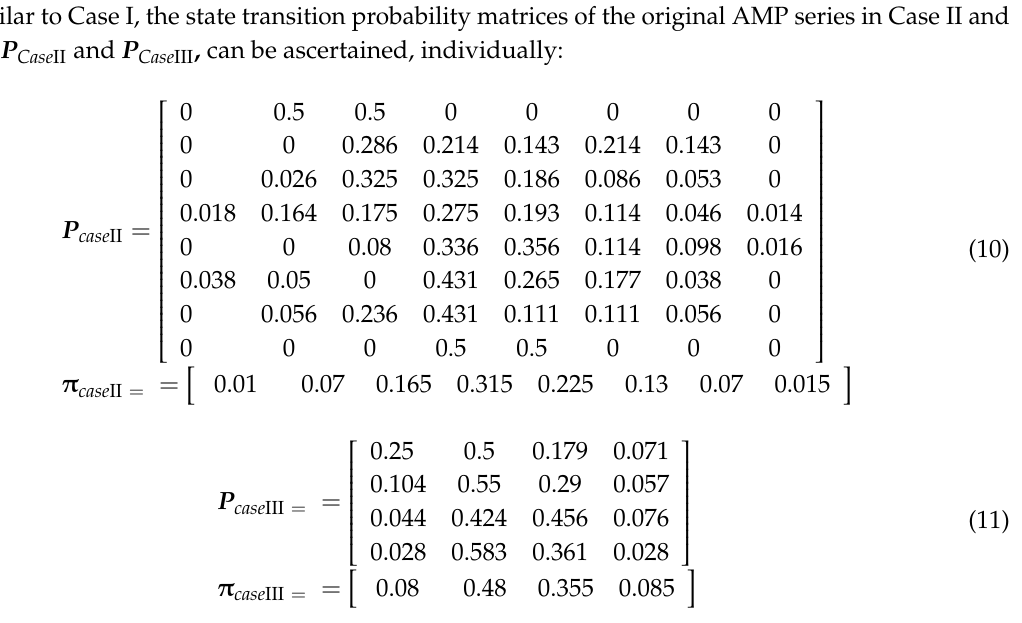
Figure 4. The schematic principle of the state transition chain in the simulation.